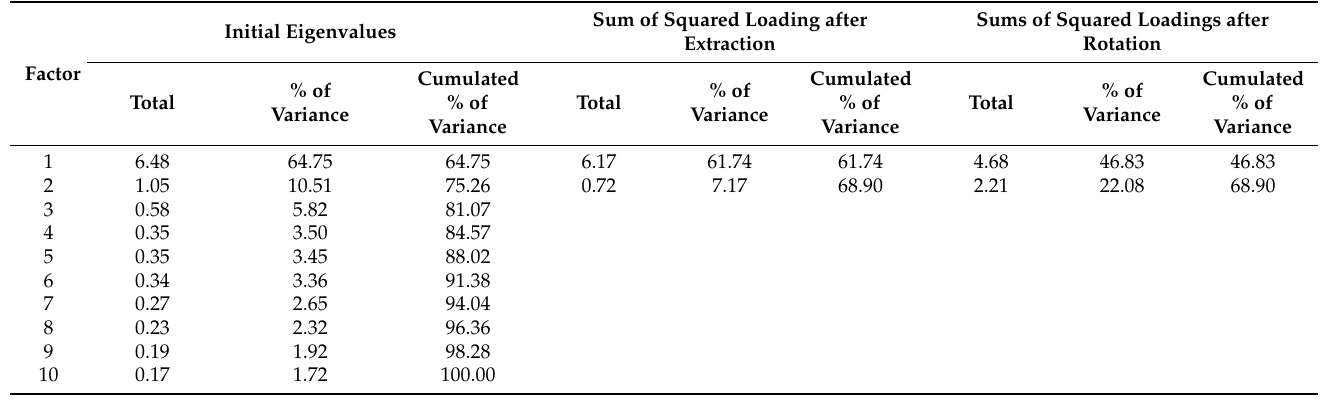
Table 4. Total variance explained by the two-factor latent structure of the scale.